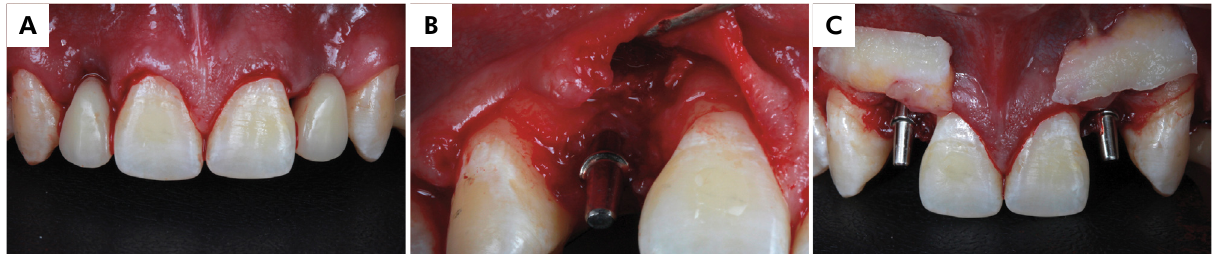
Figure 4. To provide a better esthetic outcome, surgical crown lengthening was performed on both maxillary central incisors (a). There was no facial bone loss at the implants’ facial aspect (b), but there was a large ridge deficiency in volume. Two thick CTG were harvested from the palate to compensate ridge volume loss and increase the tissue thickness (c).